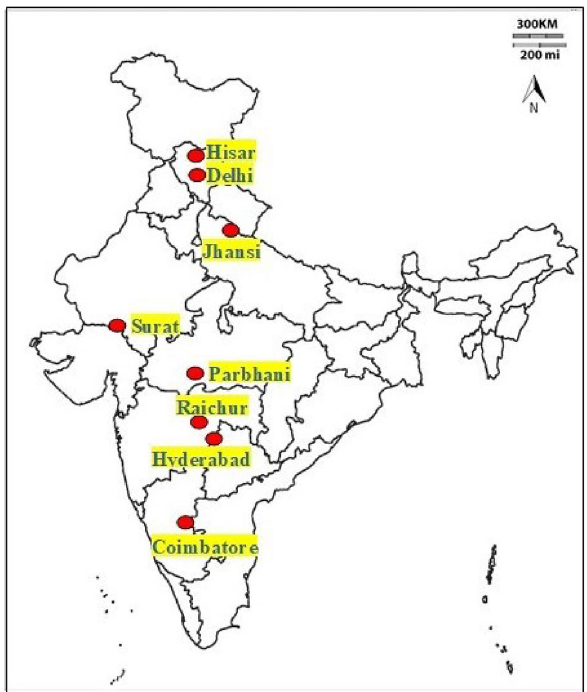
Figure 5. Map depicting geographic locations from where C. partellus larvae were